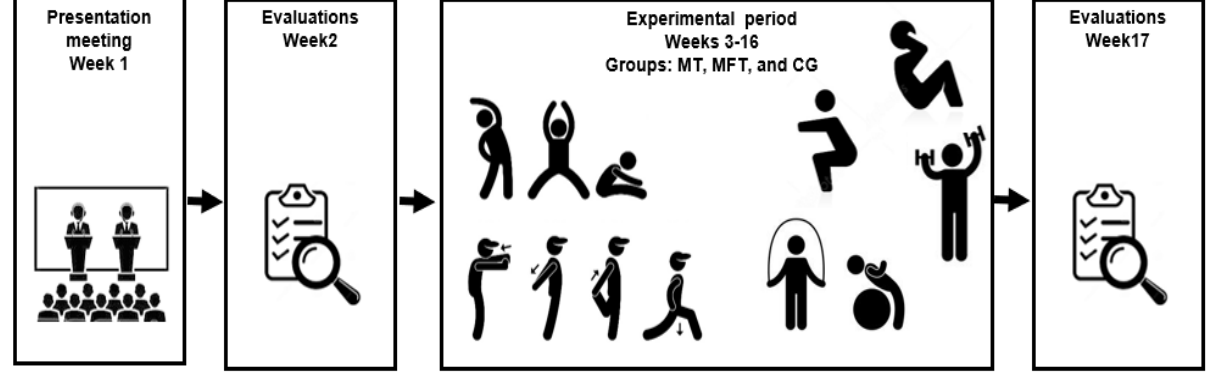
Figure 1. Study design. CG; control group; MFT, multicomponent and flexibility training group; MT, multicomponent training.